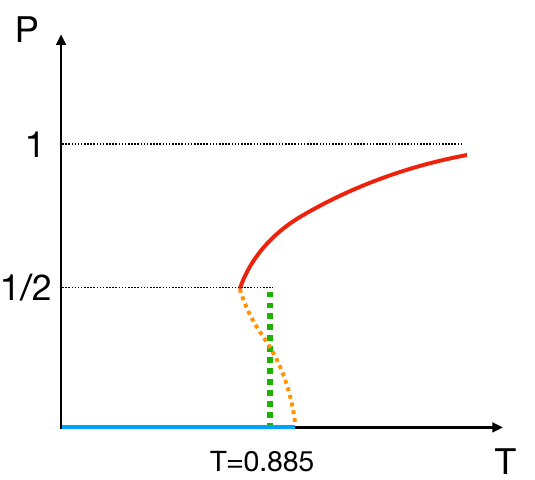
Figure 9. A sketch of the temperature dependence of the Polyakov loop in the d = 9 Yang-Mills ma- trix model [9]. Red, orange and blue lines represent the phases dominant at large N , in the canonical or microcanonical ensemble. The red and blue lines represent the completely deconfined and con- fined phases, which minimize the free energy in the canonical ensemble. The orange dotted line is the partially deconfined phase, which maximizes the free energy. In order to emphasize that this phase is not favored in the canonical ensemble, we used the dotted line. (Note however that this phase is stable in the microcanonical ensemble.) In the canonical ensemble, there is a first order transition near T = 0 . 885 . We will study the properties of the configurations at T = 0 . 885 , varying the value of P from 0 to 1 , along the green dotted line. Ref. [9] found that E and R change as (4.2) and 2